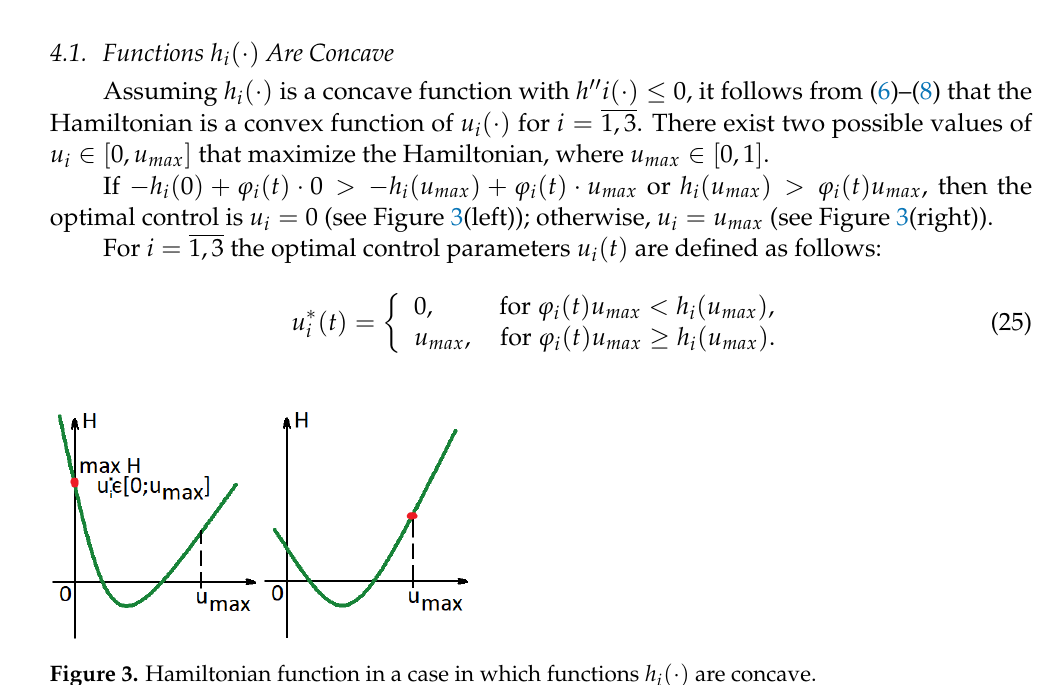
Figure 3. Hamiltonian function in a case in which functions h i ( · ) are concave.